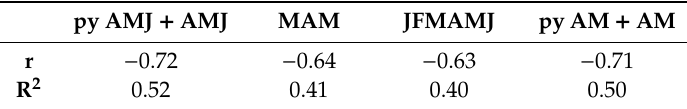
Table 2. Correlation coe ffi cient (r) and explained variance (R 2 ) between the Chahar Bagh Juniper δ 18 O chronology and precipitation.